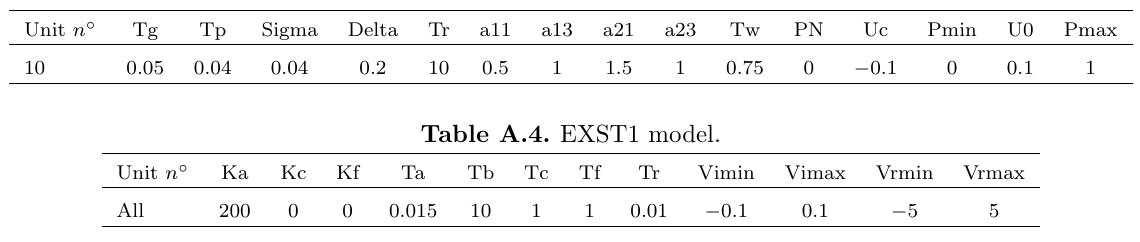
Table A.3. IEEEG3 governor model.